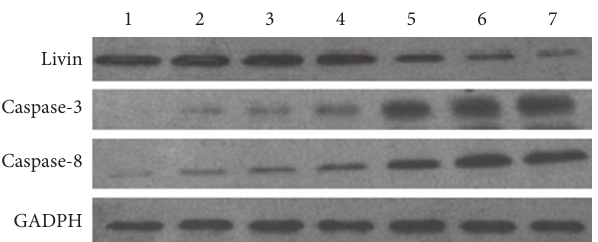
Figure 2: Western blots of Livin, caspase-3, and caspase-8